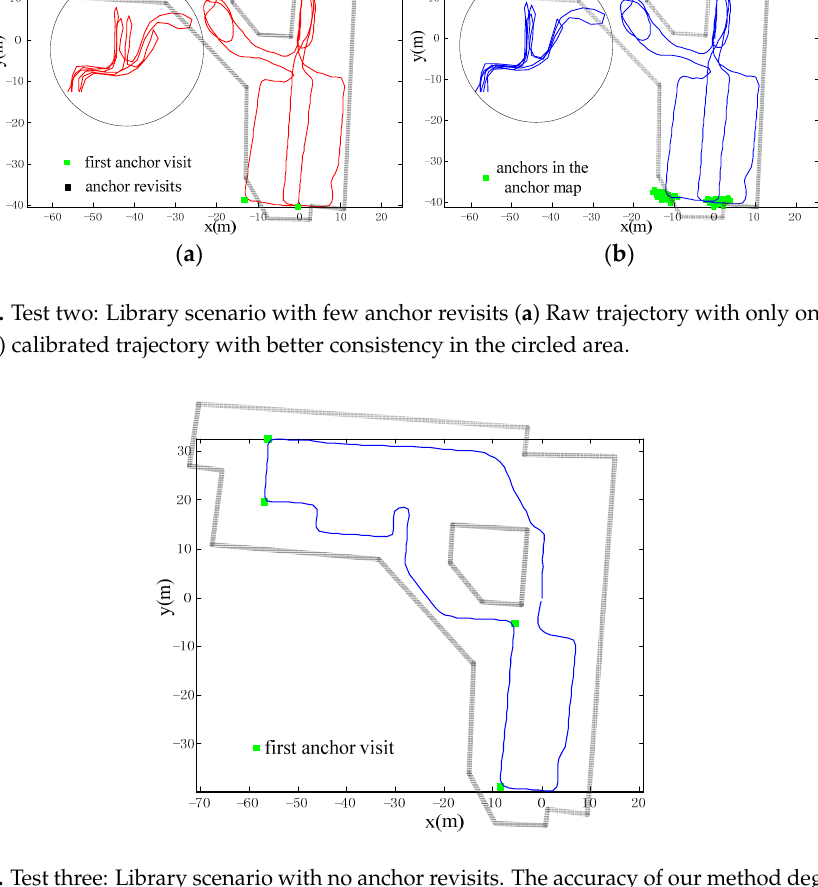
Figure 14. Test three: Library scenario with no anchor revisits. The accuracy of our method degenerates to the raw trajectory. Table 1 is a summary of quantitative results, including the heading error and the positioning errors (the percentage of positioning errors relative to the total travelled length is shown in the brackets) from the three tests, which shows that: with anchor revisits, the method is effective in with no anchor revisits, the accuracy will degenerate to that of the raw trajectory (the minor difference is due to the randomness of noise added to the particles). Table 1. Summary of the results from the tests with different amounts of anchor revisits.